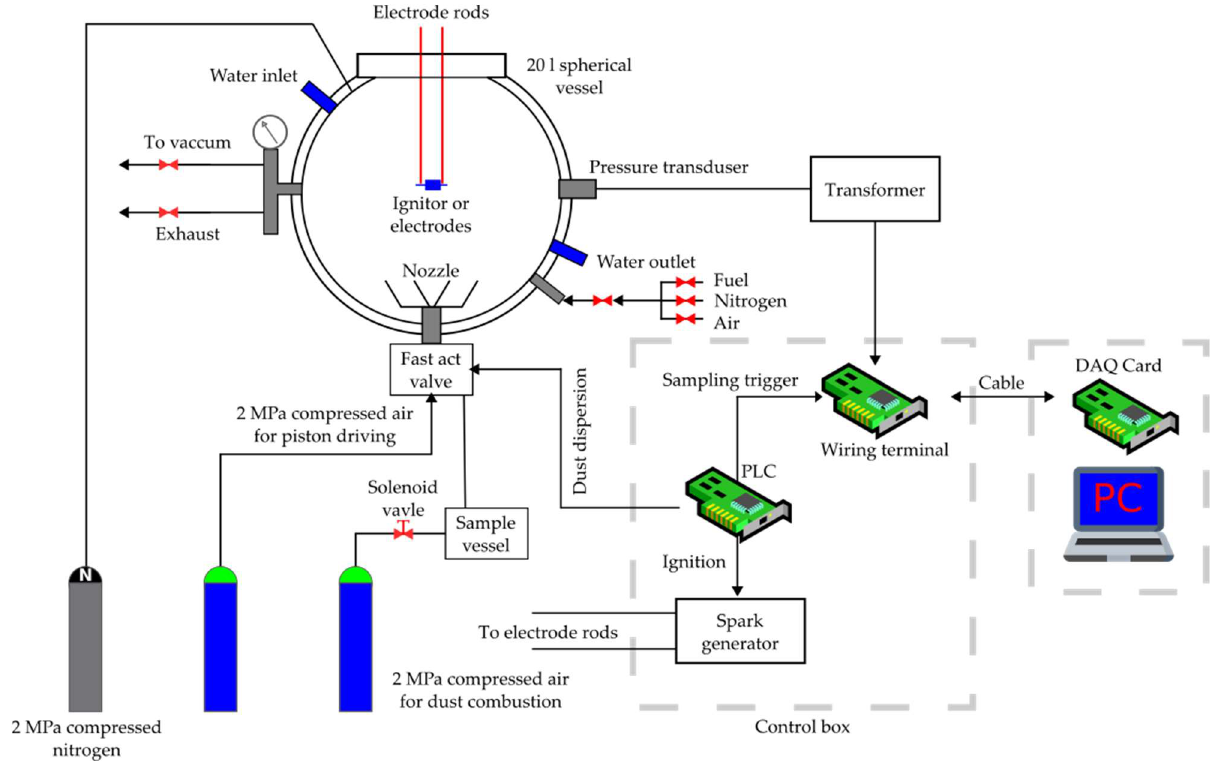
Figure 1. Spherical measurement device for explosion pressure Pmax, pressure increase rate (dP/dt)max, explosion index K St , minimum explosion concentration MEC, and decreasing oxygen concentration LOC of the Holi dust cloud.